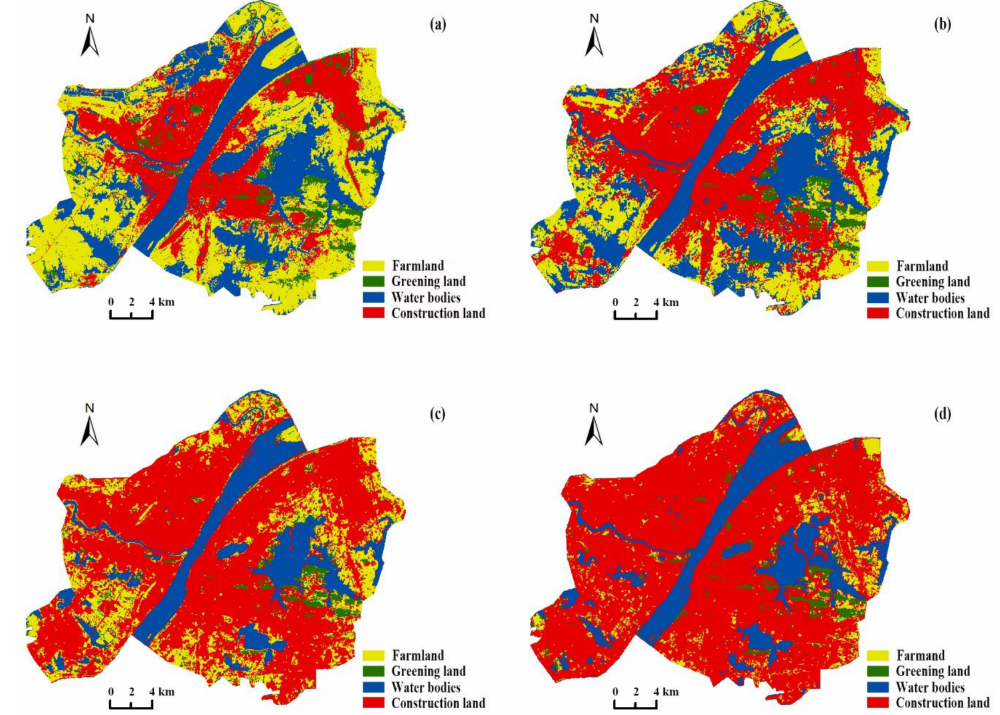
Figure 4. Spatial distribution of land use / land cover in 1987 ( a ), 1996 ( b ), 2007 ( c ) and 2016 ( d ). Table 5. Area statistics of di ff erent land use / land cover (LULC) categories in 1987, 1996, 2007 and 2016 in Wuhan (km 2 ). 1987 LULC Category Farmland (Fa.) 264.5 Greening land (Gr.) Water bodies (Wa.) Construction land (Co.) Table 6. Area changes (km 2 ) of each LULC category during four observed sub-periods in Wuhan. 1987–1996 LULC Category % Area Change % Farmland (Fa.) Construction land